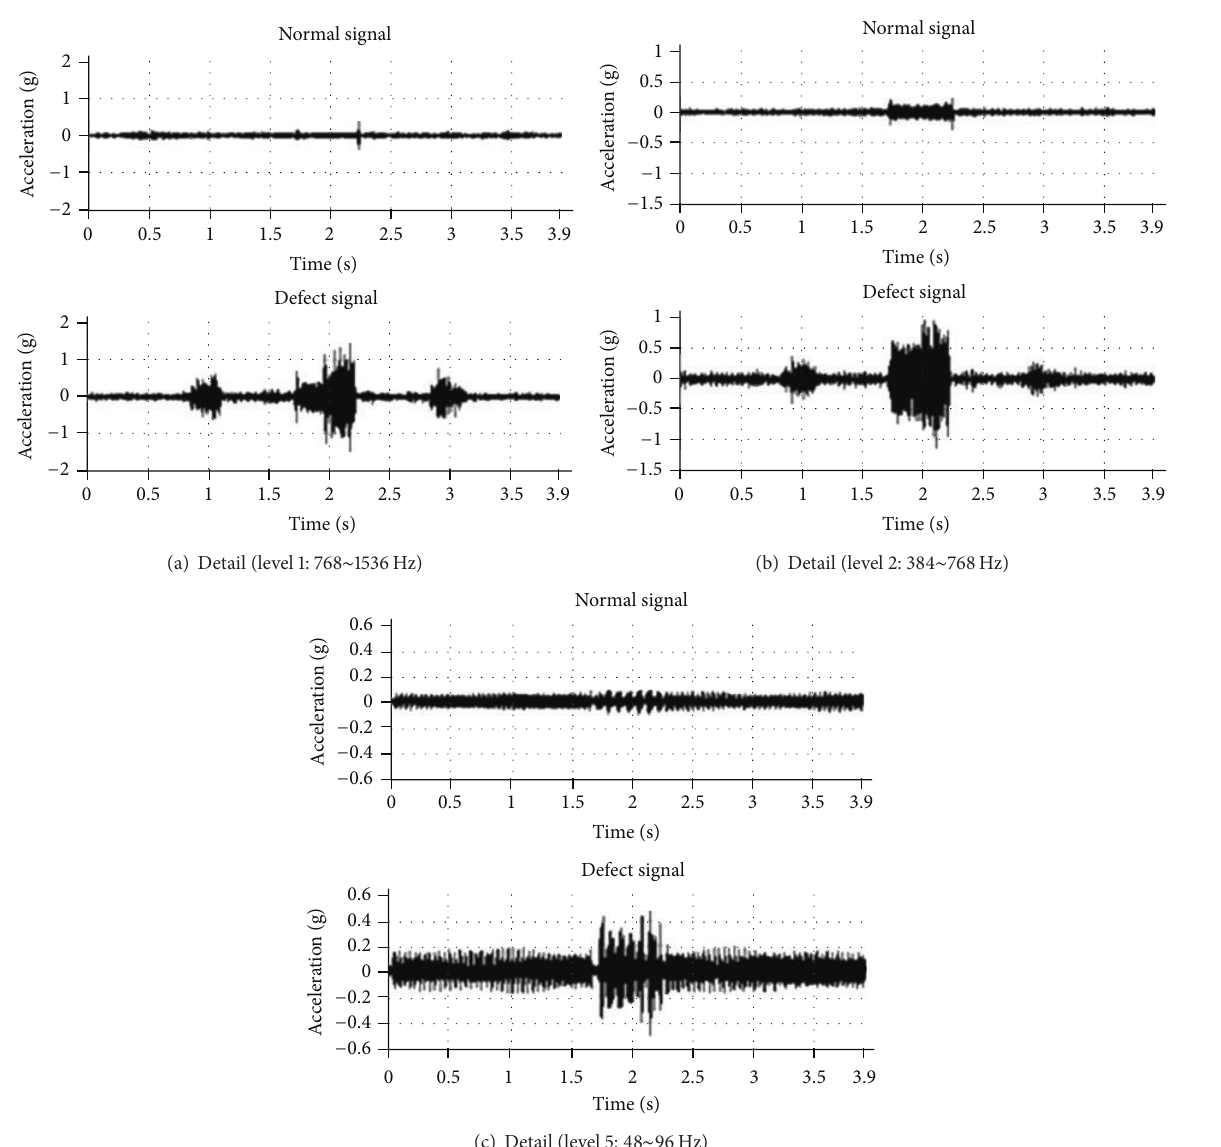
Figure 11: Wavelet transform of normal and defect signals for one reciprocation of ball-screws during 4 s when the defect is at the center of screw